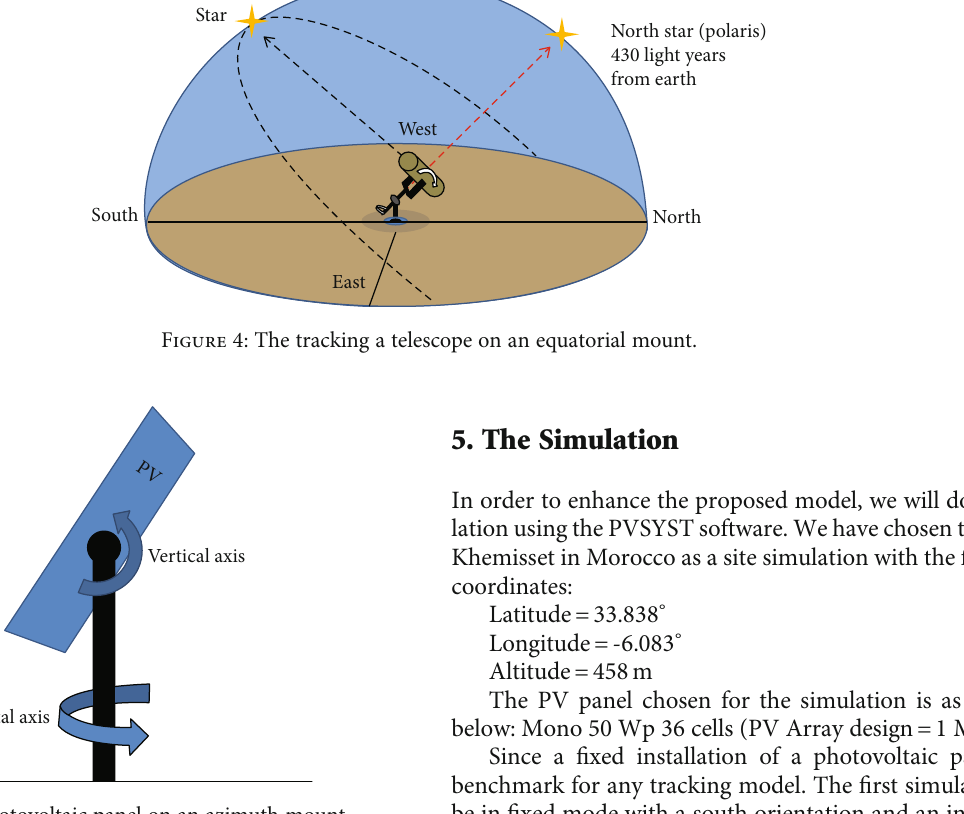
Figure 5: A photovoltaic panel on an azimuth